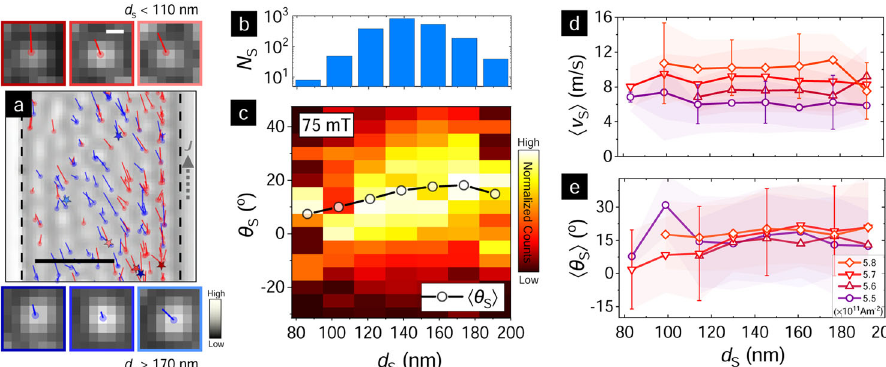
Fig. 4 Skyrmion size effect on fl ow dynamics. a Representative cropped MFM image (scale bar: 1 μ m) at μ 0 H ≃ 75 mT showing the evolution in plastic fl ow of skyrmions with varying size d d S . The smallest 25% (red) and largest 25% (blue) of S are highlighted. Overlaid dots correspond to initial skyrmion positions and lines show the extent of motion. Zoomed insets at top and bottom (scalebar: 100 nm) show selected small (top, < 110 nm) and large (bottom, >170 nm) skyrmions for comparison. b Binned histogram distribution of skyrmions, N S , based on their size, d S — which varies over 80 – 200 nm (details in SM7). c 2D histogram color plot of skyrmion de fl ection, θ S against d S for μ 0 H = 75 mT across all currents in the plastic fl ow regime. The data were binned by d S and normalized in each bin for this plot. Solid markers show the average de fl ection, 〈 θ S 〉 , for each d S bin. Average velocity 〈 v S 〉 ( d ) and angular de fl ection 〈 θ S 〉 ( e ) for skyrmions in each d S -bin for J over (5.5 – 5.8) × 10 11 A/m 2 . Shaded regions represent the standard deviation, also emphasized by error bars for selected points.